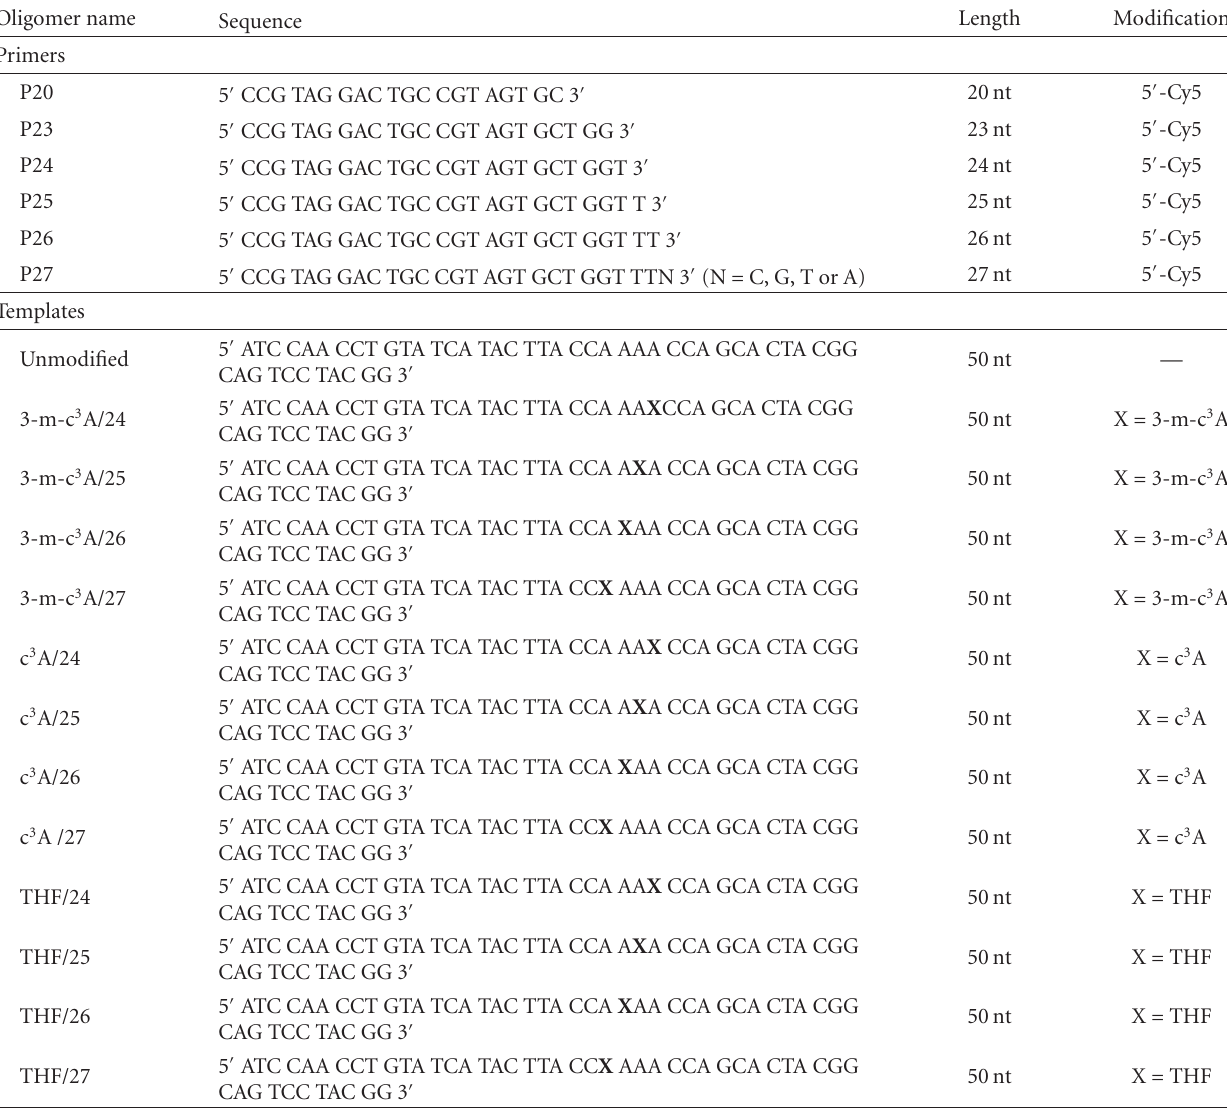
Table 1: Sequences of oligomers and primers used in the